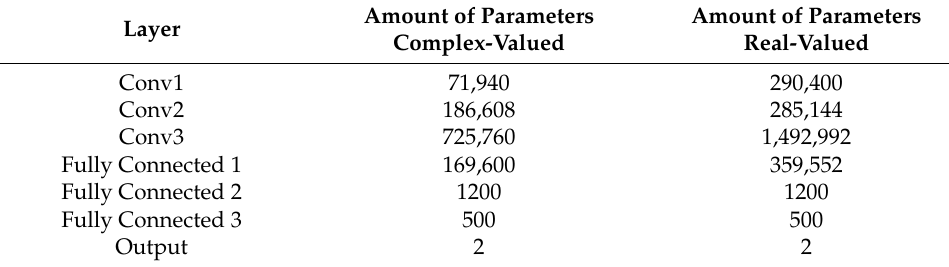
Table 5. Number of parameters in the networks